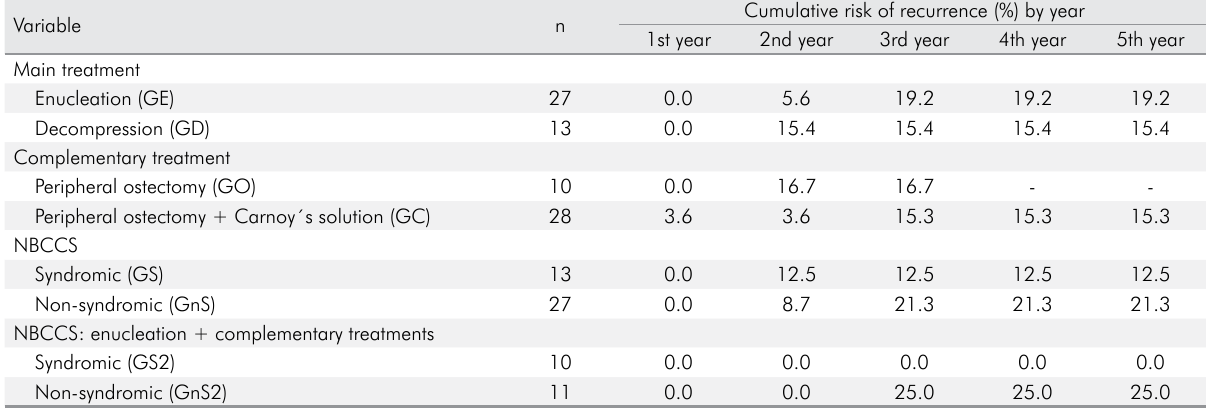
Table 2. The cumulative risks of recurrence (%) in the sample groups are summarized.